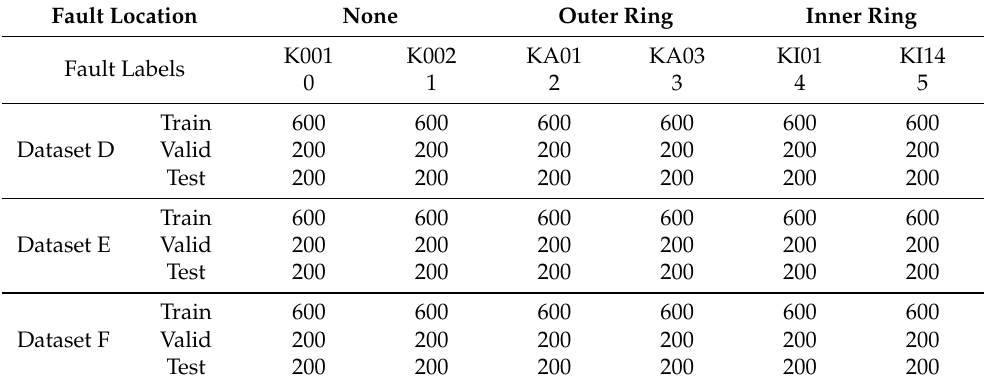
Table 9. Dataset constructed based on PU bearing dataset.